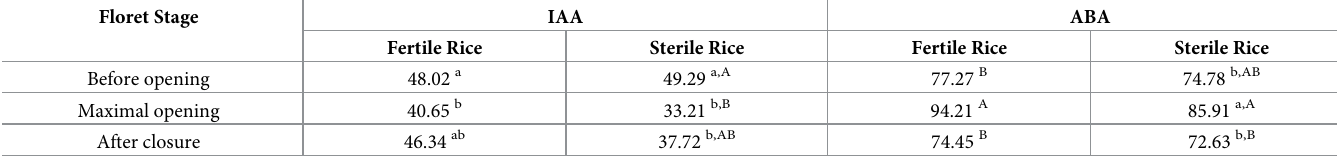
Table 6. Endogenous levels of IAA and ABA in rice floret (ng/g.FW). Floret